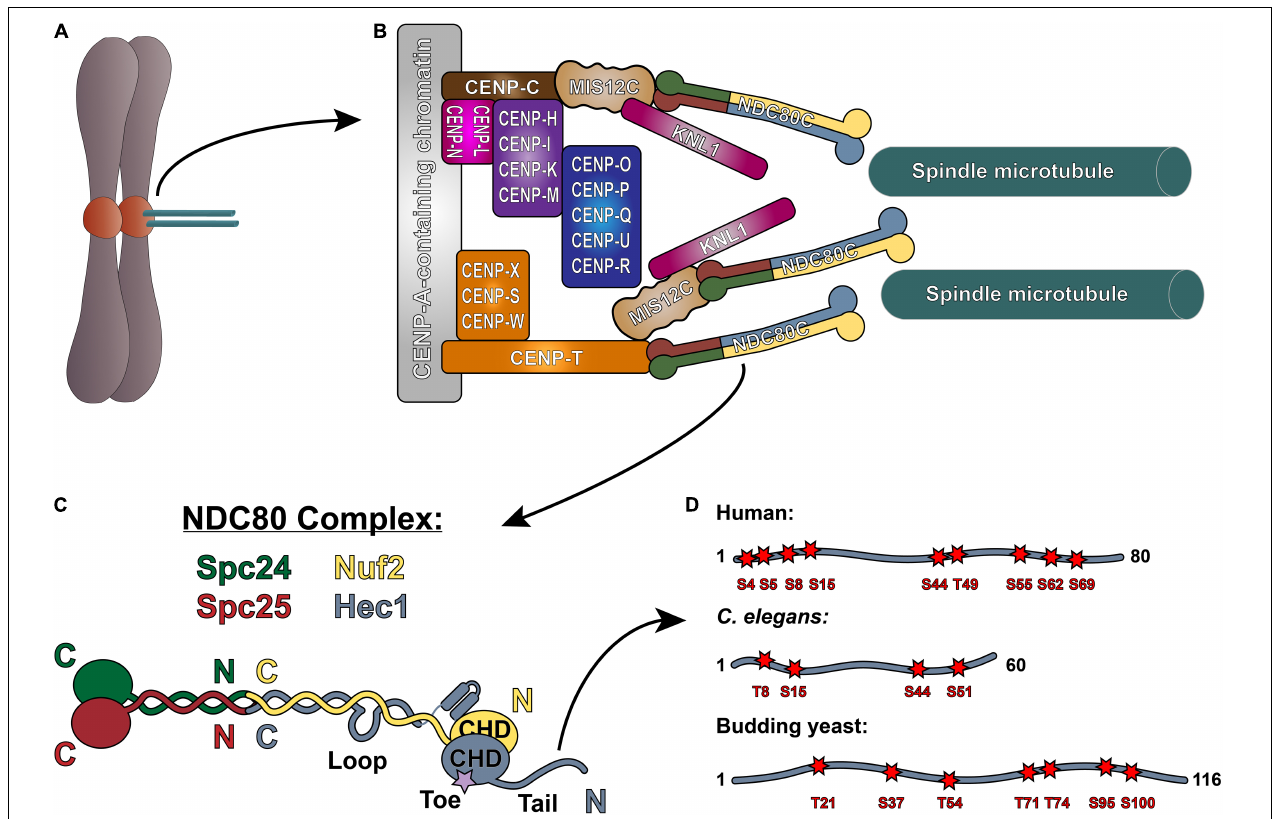
FIGURE 1 | The NDC80 complex at the kinetochore-microtubule interface. (A) Mitotic chromosome. (B) Organization of the kinetochore-microtubule interface in vertebrate cells. The foundation of the kinetochore is the CCAN, or the Constitutive Centromere Associated Network, which binds to CENP-A-containing centromeric chromatin. The CCAN is composed of 16 subunits, organized in multiple subcomplexes including: CENP-L/N; CENP-O/P/Q/U/R; CENP-H/I/K/M; CENP-T/W/S/X; and CENP-C. CENP-C recruits the KMN “network” (composed of KNL1, the MIS12 complex, and the NDC80 complex) through its direct association with the MIS12 complex. CENP-T also recruits the NDC80 complex alone, as well as the KMN network through binding the MIS12 complex. (C) Architecture of the NDC80 complex. The C-termini of Spc24 (green) and Spc25 (red) form the kinetochore-targeting domain which binds either the MIS12 complex or CENP-T. The N-terminal regions of Spc24 and Spc25 form a coiled-coil domain that tetramerizes with the C-termini of Nuf2 (yellow) and Hec1 (blue). The N-terminus of Hec1 is comprised of a well-ordered CH domain, which contains the high affinity microtubule-binding “toe” region, and the tail domain which is also implicated in microtubule binding. The ∼ 40 amino acid loop domain of Hec1 is also indicated on the schematic. (D) Representation of the Hec1/Ndc80 tail domains from human, Caenorhabditis elegans , and the budding yeast Saccharomyces cerevisiae . Shown are the mapped and putative Aurora kinase phosphorylation sites. The human sites shown are Ser4, Ser5, Ser8, Ser15, Ser44, Thr49, Ser55, Ser62, and Ser69. The C. elegans sites shown are Thr8, Ser18, Ser44, and Ser51. The budding yeast sites shown are Thr21, Ser37, Thr54, Thr71, Thr74, Ser95, and Ser100 (see text for